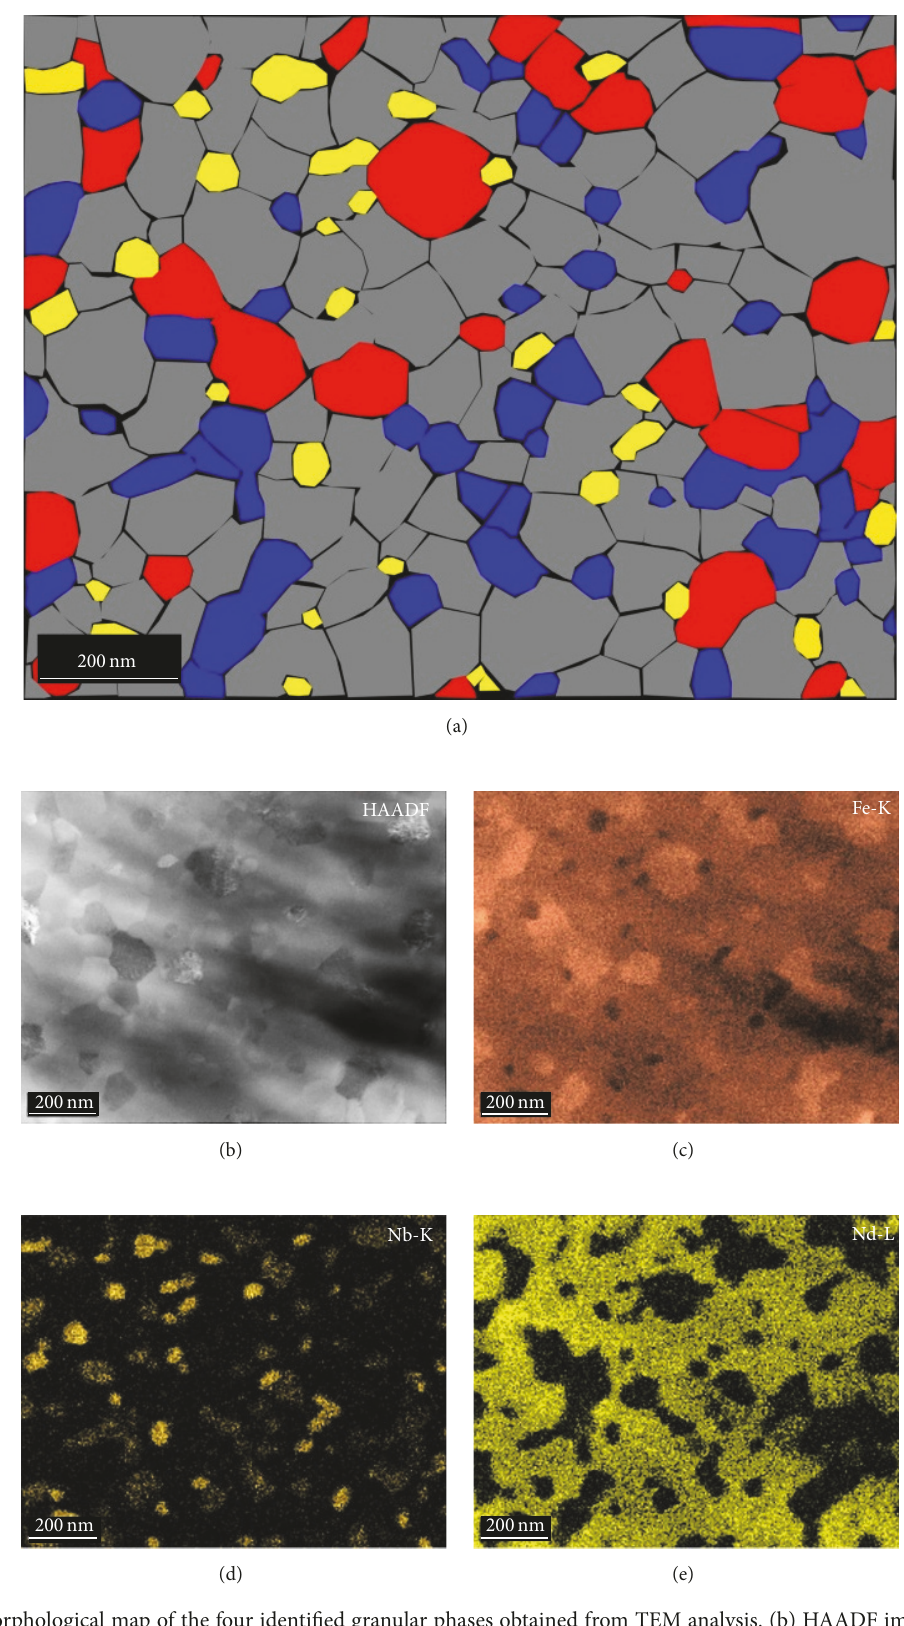
Figure 12: (a) Morphological map of the four identified granular phases obtained from TEM analysis. (b) HAADF image (cl = 200 mm). (c–e) elemental (Fe, Nb, and Nd) EDX maps of sample area as shown in (b). Nd 2 Fe 14 B (grey), 𝛼 -Fe (red), Nb 6 Fe 76 B 18 (blue), and Fe 2 Nb